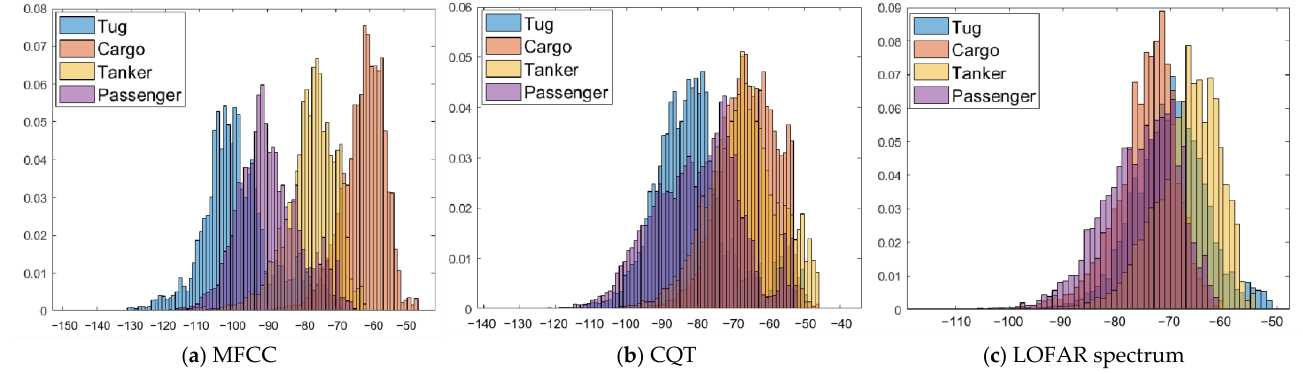
Figure 12. Statistical histograms of the MFCC, CQT, and LOFAR spectrum.